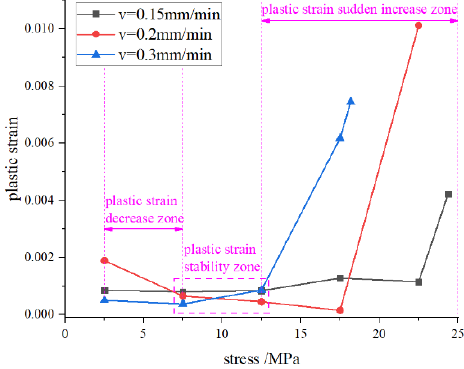
Figure 4. Change process in plastic strain for different loading rates.